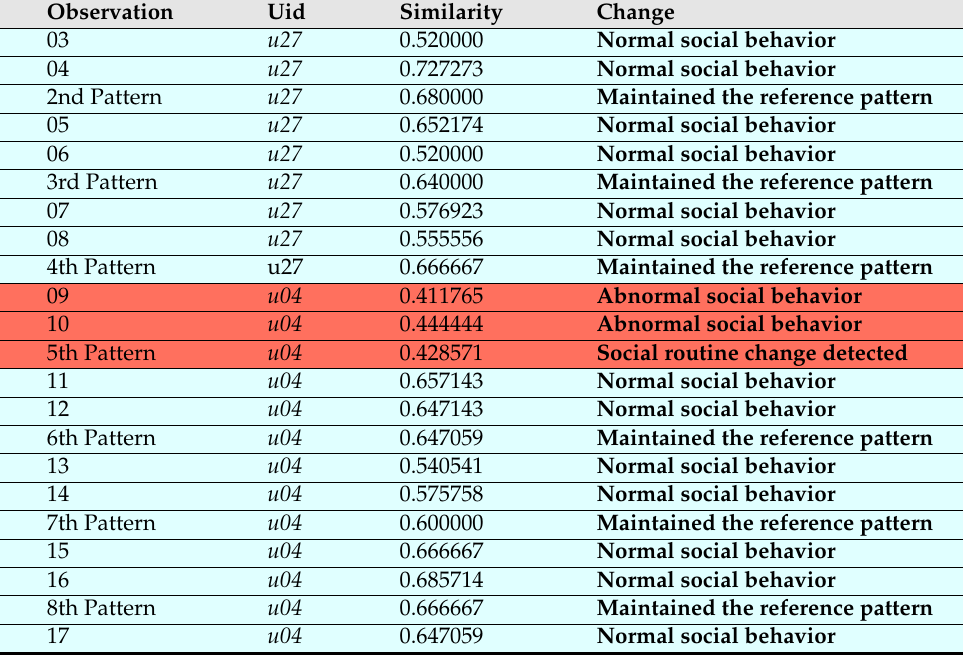
Table 2. The flow of social behavior change detection. Red lines represent the identification of abnormal behaviors and social routine change. Observation Uid Similarity